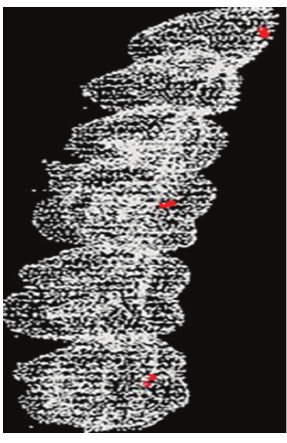
Figure 6: The extracted feature point set 𝑃 .